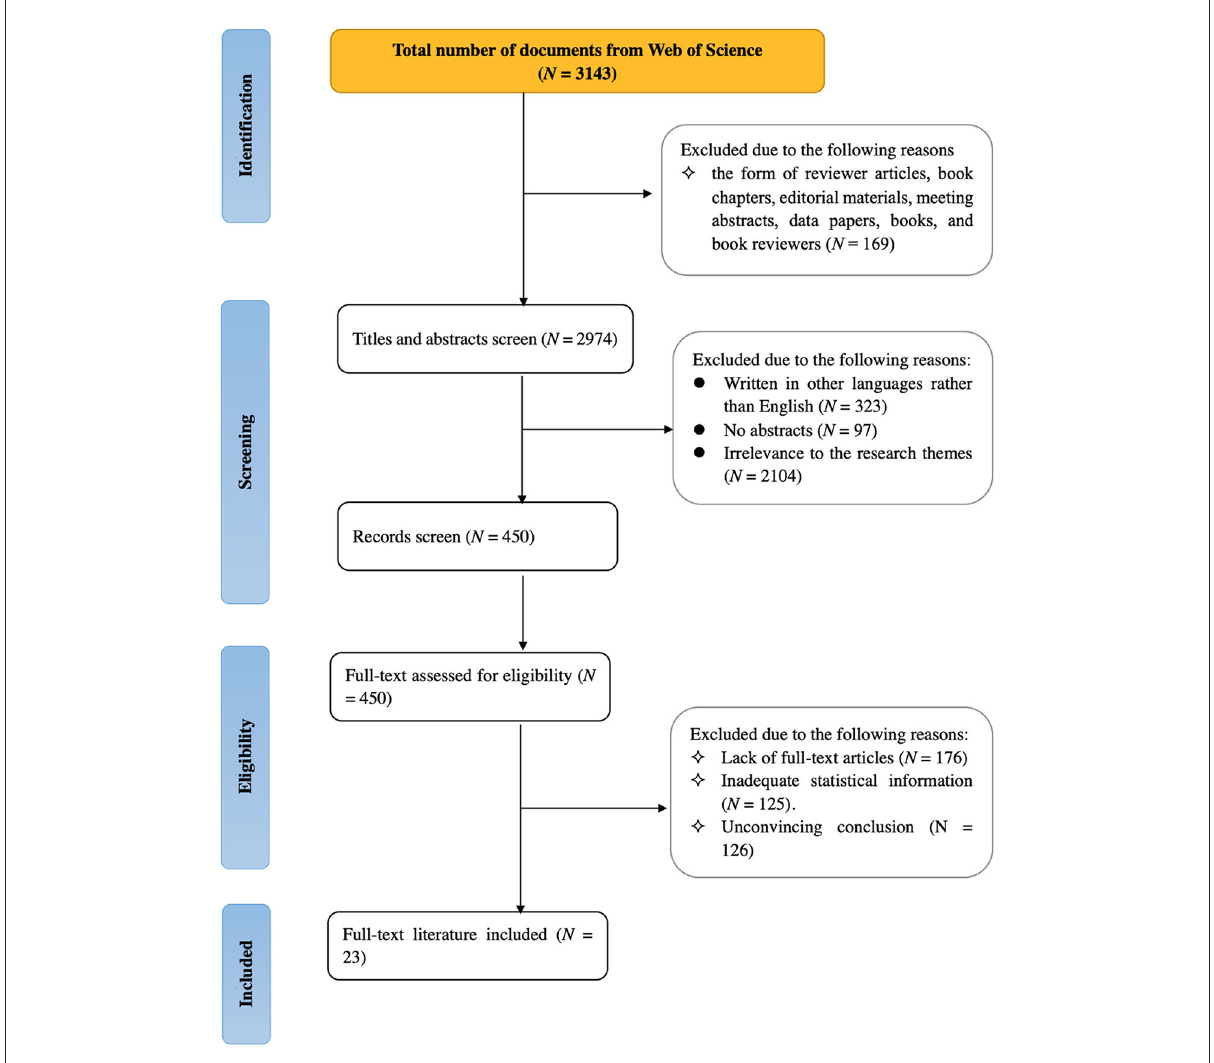
FIGURE2 A flow diagram of the study selection based on